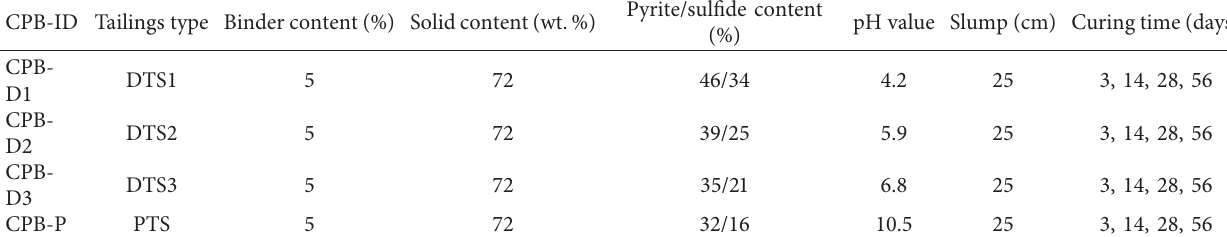
Table 3: Different mixture recipes of CPB materials manufactured with dam